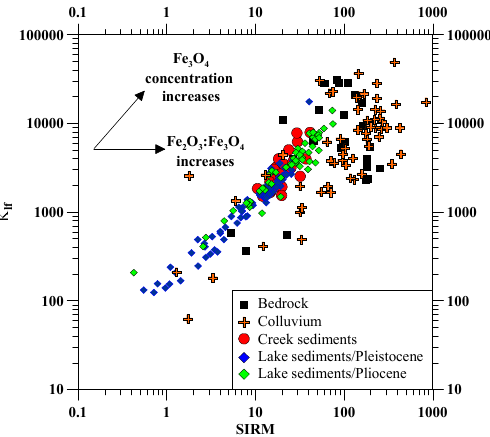
Fig. 11. Biplot of magnetic susceptibility ( κ lf ) versus saturation re- manent magnetization (SIRM). Deviations from a linear relation- ship between the two parameters in different sample types indicate variation in the proportions of the constituting magnetic minerals in rock/sediment magnetic assemblages. Catchment rocks, including colluvium and bedrock, show widely varying magnetic properties, whereas data from creek sediments are notably clustered. In contrast to catchment rocks, lake sediments indicate a linear relationship be- tween the two magnetic parameters. This suggests a homogenous magnetic assemblage in the sediment column.